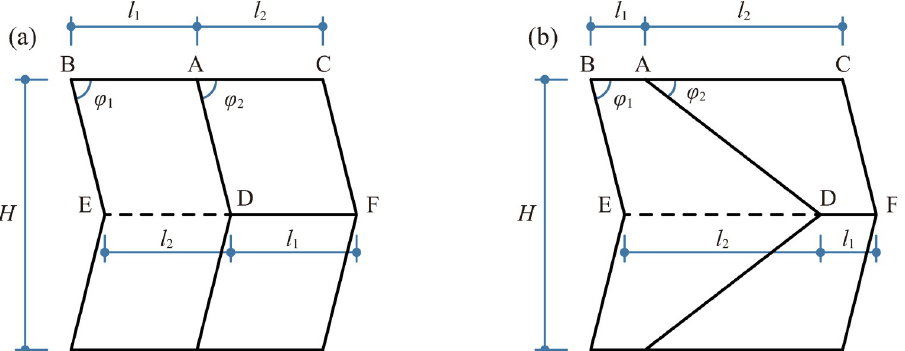
Fig 1. A regular Miura origami and a curved Miura origami when fully unfolded. (a) a regular Miura origami ( φ 1 = φ 2 ); (b) a curved Miura origami ( φ 1 6¼ φ 2